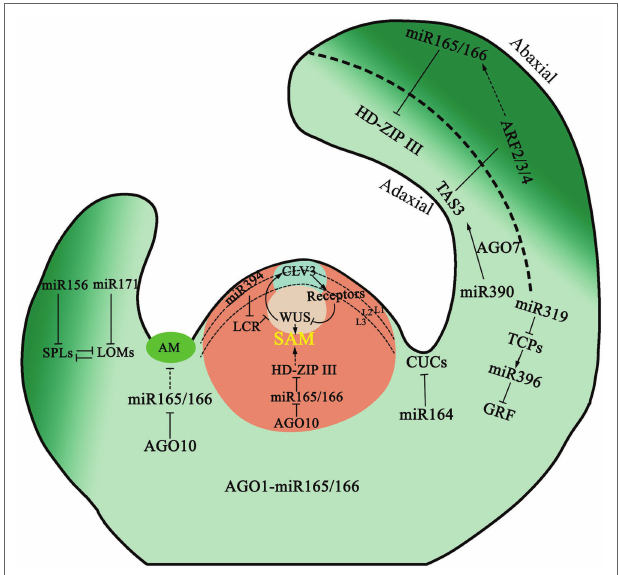
FIGURE 2 | Model for the role of miRNAs in shoot apex. miR394 synthesized at the protoderm represses LCR in subtending cells, which leads to the activation of the WUSCHEL (WUS) transcription factor to maintain stem cell identity and CLAVATA3 (CLV3) peptide expression. ARGONAUTE10 (AGO10) specifically sequesters miR165/166 and antagonizes its activity in the meristematic cells, thus regulating SAM and AM development. ARGONAUTE1 (AGO1) is expressed ubiquitously in the apex, recruit miR165/166 to form RNA-induced silencing complex (RISC). The adaxial and abaxial domains of leaves are established during leaf primordia emergence. HD-ZIP III transcription factors are restricted to the adaxial side by the action of miR165/166. In turn, AUXIN RESPONSE FACTOR 2/3/4 are restricted to the abaxial side by the action of TAS3 ta-siRNA. Two NAC-domain transcription factors are post-transcriptionally regulated by miR164 in embryonic meristem initiation, boundary size control, and cotyledon establishment. miR319 and miR396 target several TEOSINTE BRANCHED1/ CYCLOIDEA/PROLIFERATING CELL FACTOR ( TCP ) and Growth-Regulating Factor ( GRF ) genes, respectively, and act coordinately to control leaf cell proliferation and differentiation. miR156 and miR171 synergistically regulate trichome initiation by targeting SQUAMOSA PROMOTER BINDING PROTEIN- LIKE ( SPL ) and LOST MERISTEMS ( LOM ), respectively. Arrows indicate positive regulation, whereas the dotted lines with perpendicular end bars represents a hypothesized negative